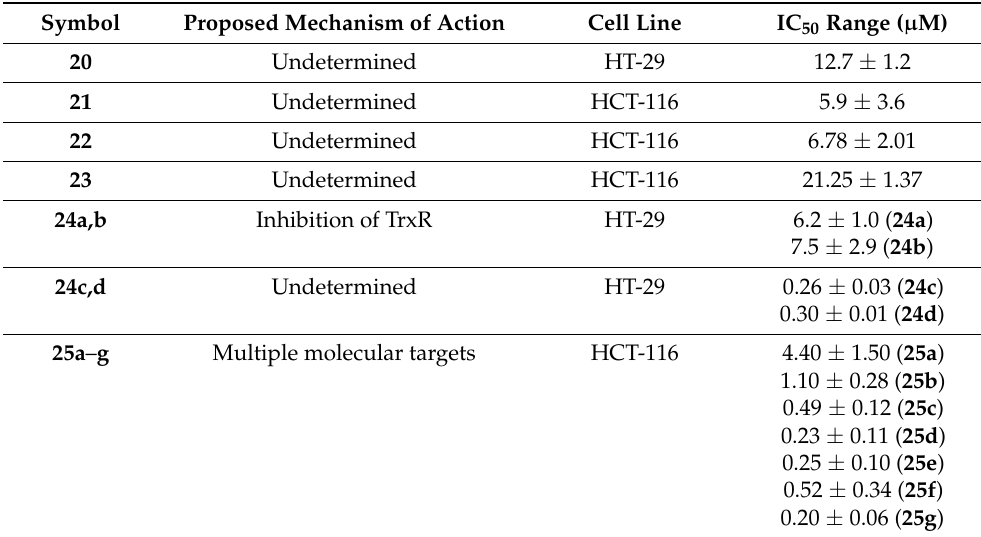
Table 4. Characterization of the anticancer properties of N-heterocyclic carbenes (NHCs).